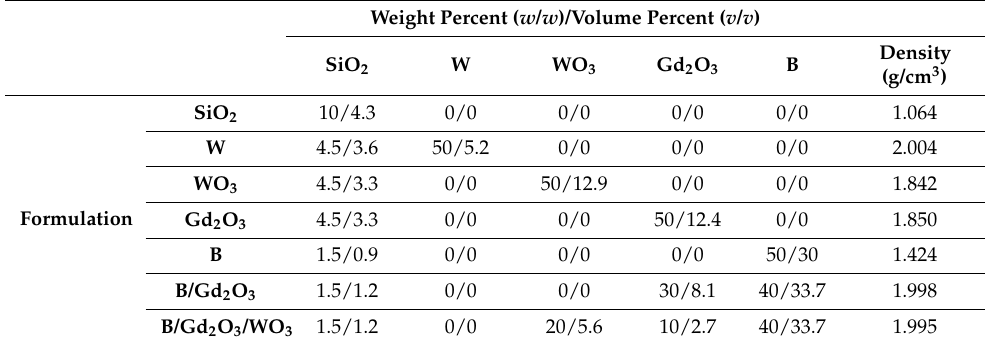
Table 1. The formulations developed and their densities along with the weight and volume percent of each filler component.